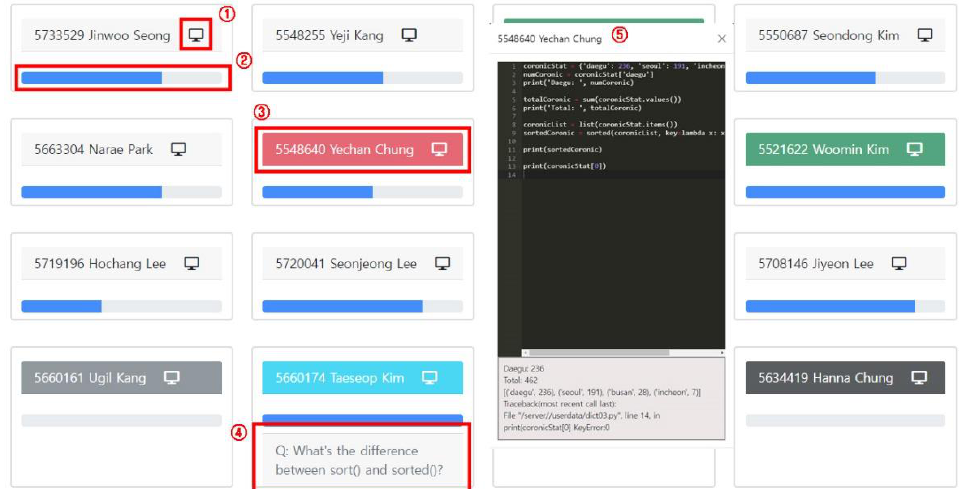
Figure 2. Real-time learning activity analysis window. ① The monitoring button allows instructors to remotely monitor students’ source code input status from their PC. ② The progress shows the progress of each student compared to the target source code in the form of a bar chart. ③ The progress status is visualized in different colors by assessing the progress/waiting/completed/error/question/absence status according to the code input status regularly received from the students. ④ The question content shows the students’ questions. ⑤ The student modal window monitors the student’s source code and shows it to the instructor.